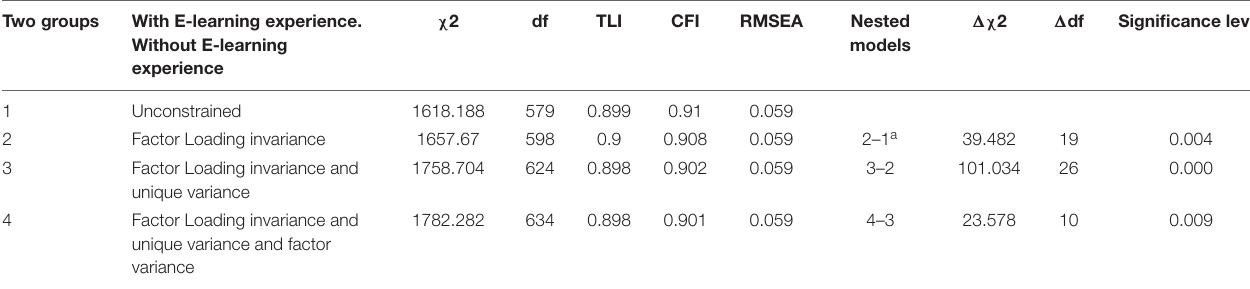
TABLE 6 | Invariance analysis of E-learning effectiveness across experience. Two